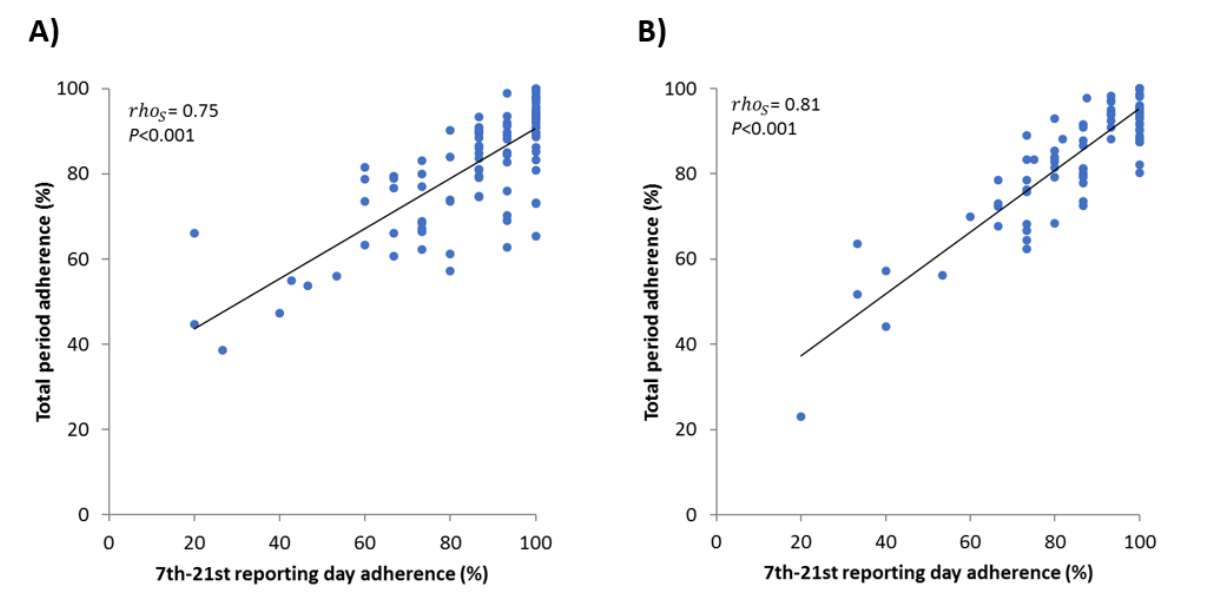
Figure 3. Correlation between adherence achieved between the seventh and the 21st reporting days and total reporting period adherence, by study